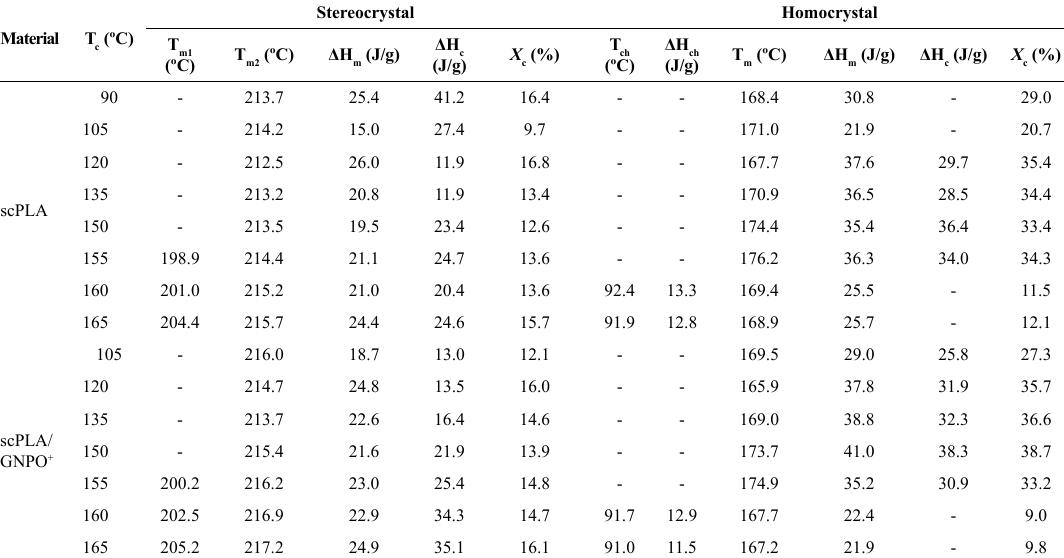
Table 3. Transition temperatures, enthalpies and degree of crystallization of scPLA and scPLA/GNPO+ nanocomposite. Material T c